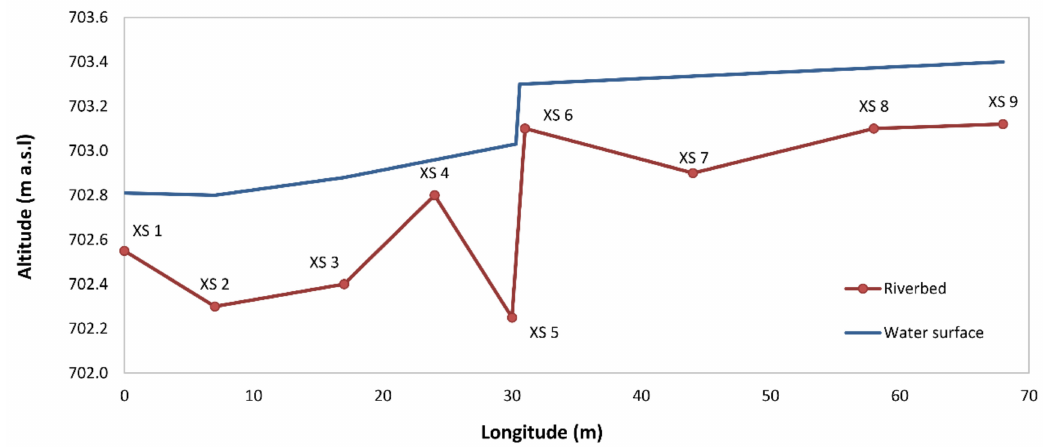
Figure 4. Longitudinal profile of the Teplica River. XS is the abbreviation for